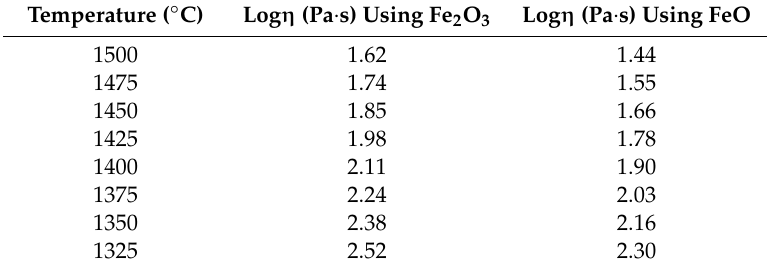
Model FactSage viscosity ( η ) values using Fe 2 O 3 or FeO as inputs. Using FeO in place of Fe 2 O 3 , the composition was the same as that for the Giordano et al.